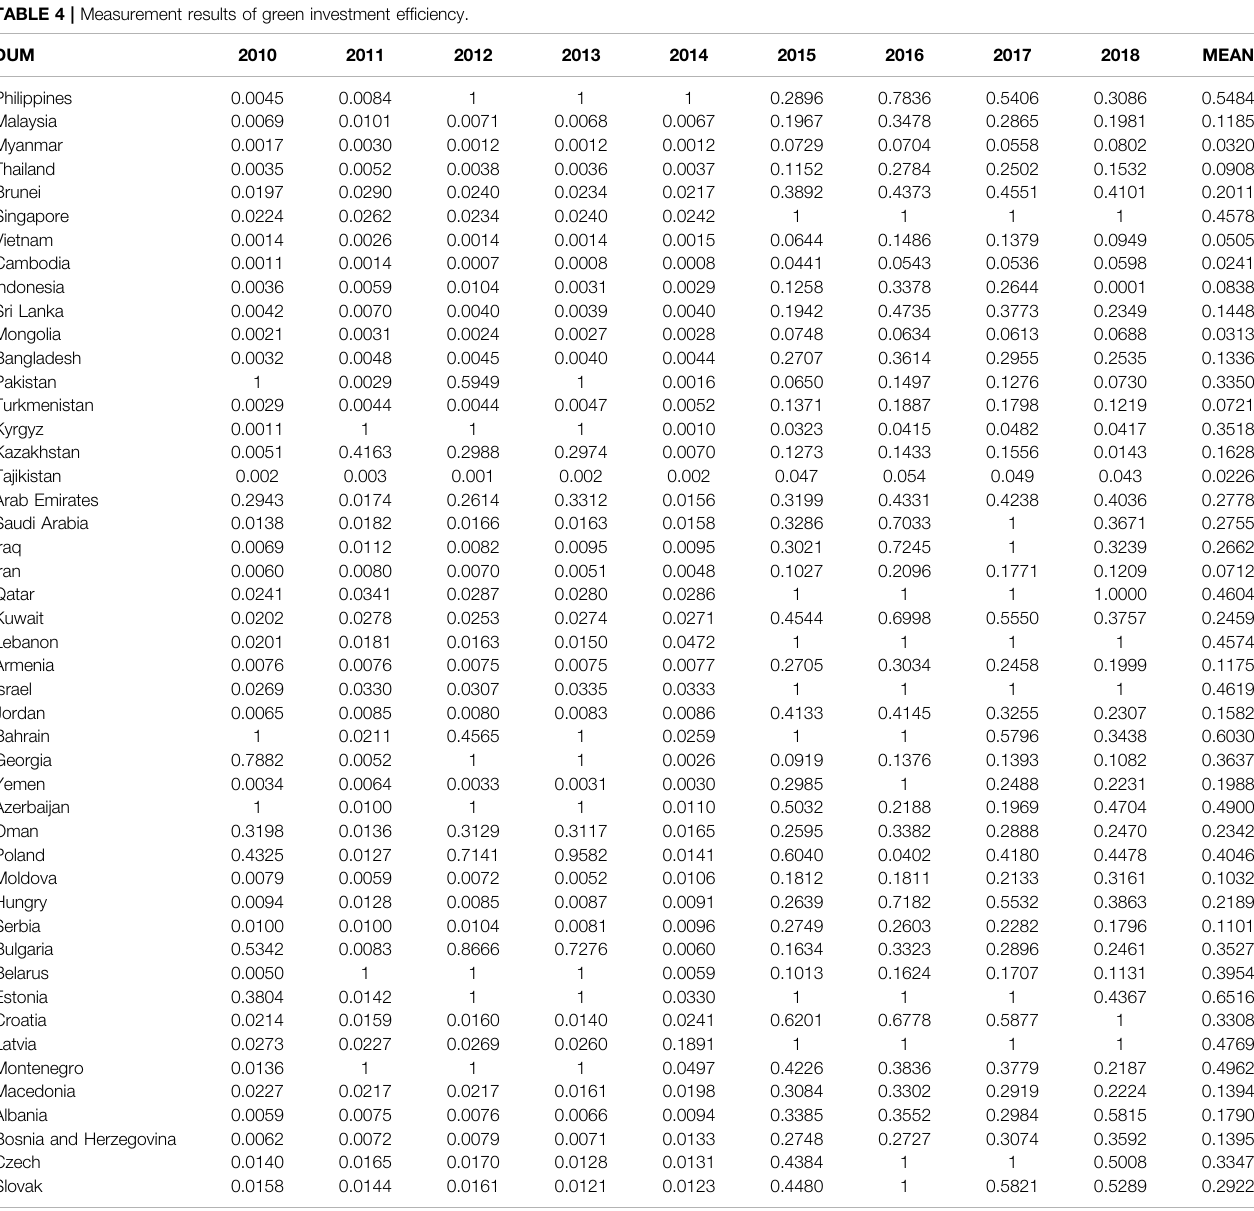
TABLE 4 | Measurement results of green investment ef fi ciency.